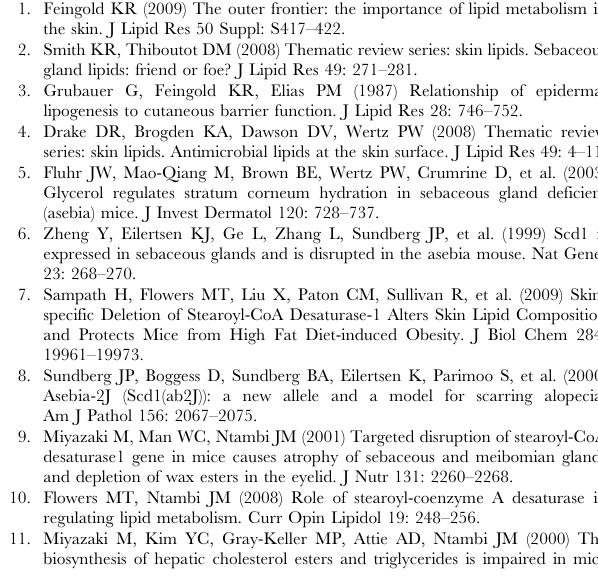
Figure S1 Characterization of SCD1 activity and lipo- calin-2 secretion in human SEB-1 sebocytes. A) The relative activity of endogenous SCD1 was measured in SEB-1 sebocytes as described in Methods . SEB-1 sebocytes display measurable conversion of 14 C-stearate into 14 C-oleate that is able to be inhibited by the small molecule SCD1 inhibitor A939572. B) Increasing concentrations of free retinol were used to measure the appearance of LCN2 secreted into the media from SEB-1 cells. At low concentrations, cells with and without SCD1 activity demonstrated a modest increase in LCN2 secretion. Higher retinol levels ( $ 1 m M) did not increase LCN2 secretion in cells with SCD1 activity possibly due to feedback inhibition, whereas SCD1 inhibited cells continued to increase LCN2 secretion when treated with up to 10 m M retinol. Table S1 Inflammation, wound healing and defense response. Changes in gene expression are reported as fold- change (FC) relative to Lox mice. Significant differences between Lox and SKO were determined as described in Methods , and for both Welch’s t-test and EBarrays the false discovery rate was set at 5%. All probe sets listed have a posterior probability of differential expression (PP of DE) . 0.639 (soft threshold) based upon analysis by EBarrays. Additionally, Welch’s t-test was used to calculate q- values and those probe sets with q-values , 0.05 were considered significant. Table S2 Miscellaneous categories. Changes in gene expression are reported as fold-change (FC) relative to Lox mice. Significant differences between Lox and SKO were determined as described in Methods , and for both Welch’s t-test and EBarrays the false discovery rate was set at 5%. All probe sets listed have a posterior probability of differential expression (PP of DE) . 0.639 (soft threshold) based upon analysis by EBarrays. Additionally,